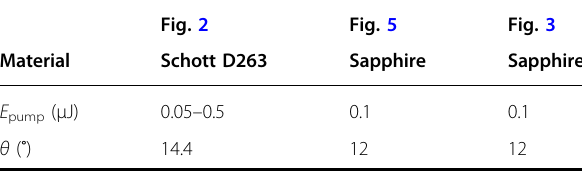
Simulations of the diffracted signal in Fig. 5 The simulations of the diffracted signal in Fig. 5 are based on numerical integration of the following expression: